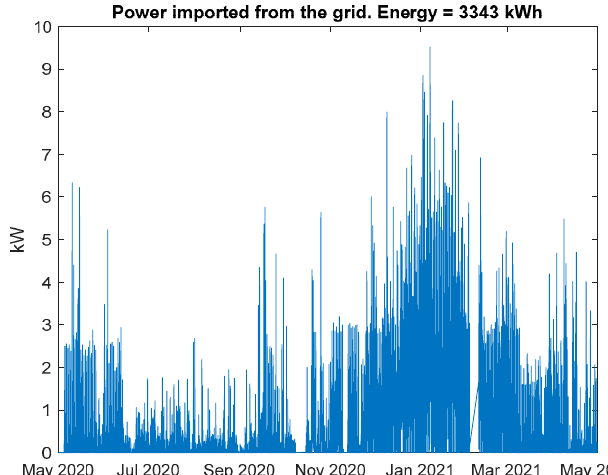
Figure 8. Power imported from the grid during the year.